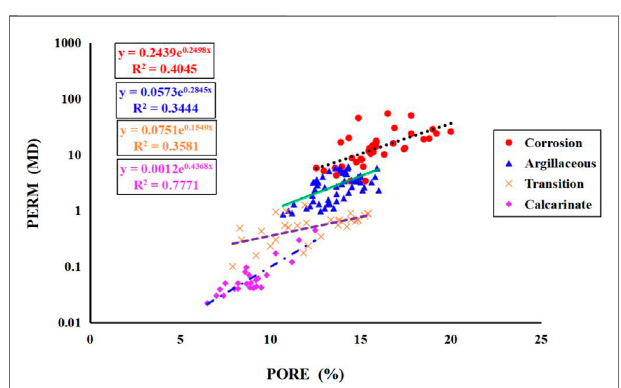
FIGURE10| Relationship betweenporosityandpermeabilityofdifferent petrophysical facies in the Es 3 reservoir.